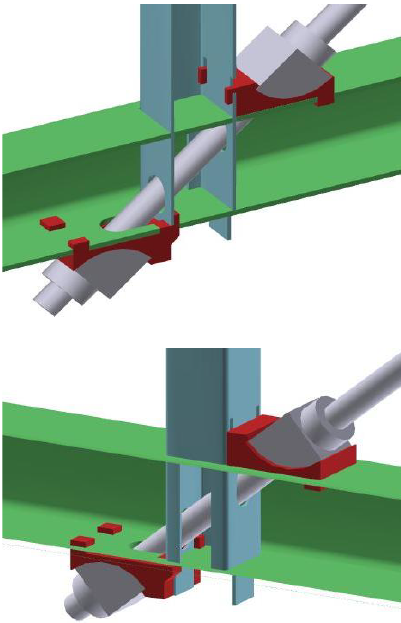
Figure 2: Section views of N type RHS joint with its details